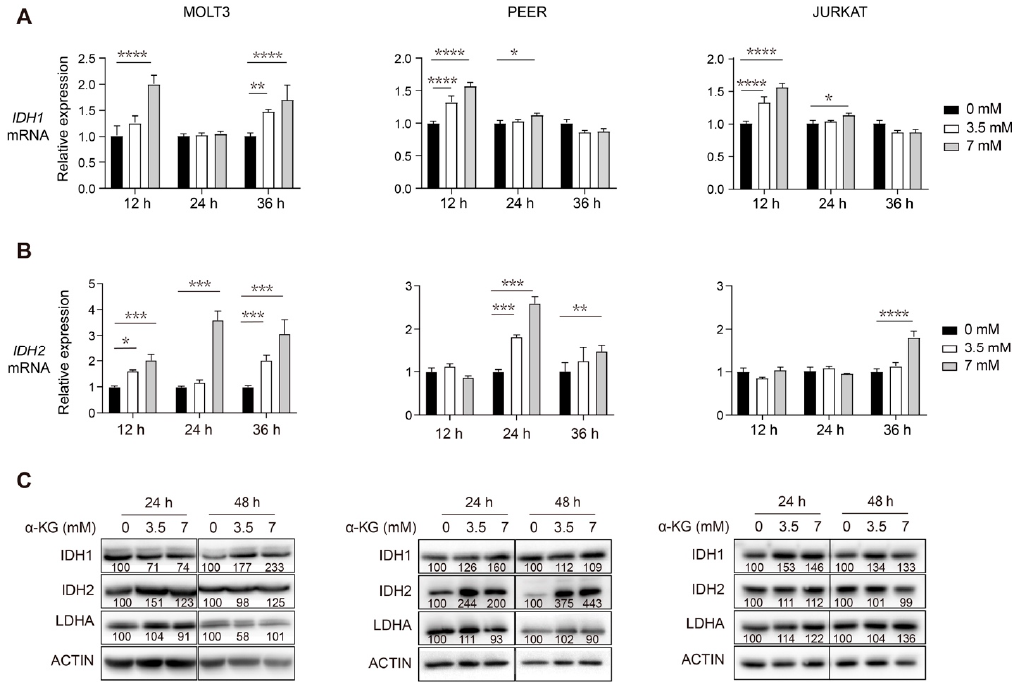
Figure 3. α -KG treatment of human T-ALL cells leads to increased transcript and protein levels of IDH1 and IDH2. ( A , B ) qRT-PCR analysis of IDH1 ( A ) and IDH2 ( B ) transcript levels at 12, 24, and 36 h post-treatment with 0, 3.5, or 7 mM of α -KG in human MOLT3, PEER, and JURKAT T-ALL cell lines. Relative fold change was analyzed using the 0 mM group as a control. The data are presented as the mean ± s.e.m, and statistical differences are calculated and normalized to the control, and determined by two-way ANOVA. ( C ) Western blotting of DLST, IDH1, IDH2, and LDHA in the same three T-ALL cell lines after 24 and 48 h of treatment with either 0, 3.5, or 7 mM of α -KG. Relative protein to ACTIN ratios are shown at the bottom of each western blotting panel. * p < 0.05, ** p < 0.01, *** p < 0.001, **** p < 0.0001.